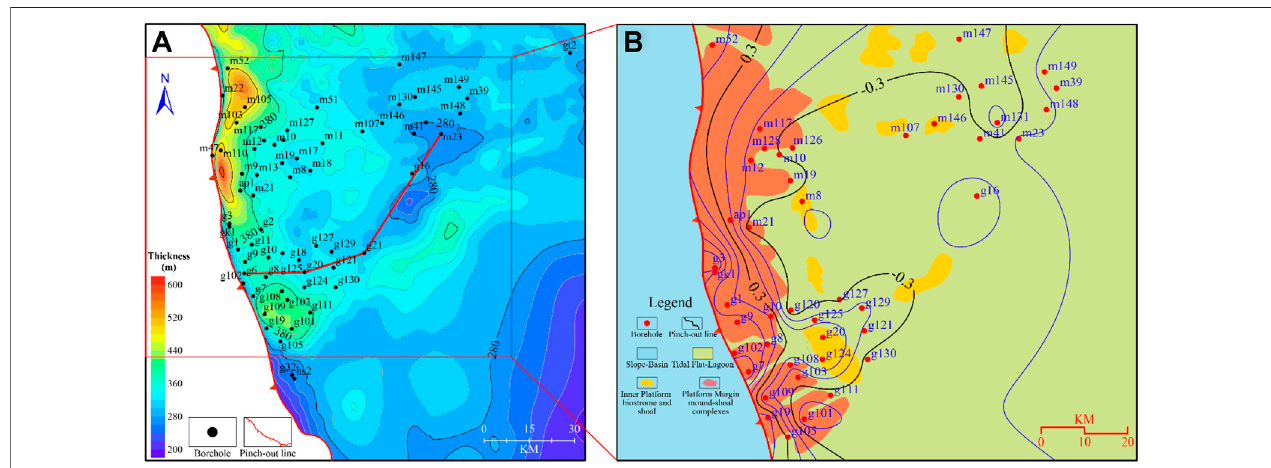
FIGURE 6 | (A) converted residual thickness of Deng Ⅳ and Z 2 dn 3 s based on seismic data. Note the banded convex structure along the pinch-out line, which referstothegreaterthicknessintheplatformmargin.DuetotheinferiortraceabilityoftheinterfacebetweenthetwomembersandtheverythinthicknessoftheZ 2 dn 3 ,the combined thickness is an acceptable approximation for the thickness distribution of the Z 2 dn 4 . (B) sedimentary facies of the Z 2 dn 4 in the GMA superimposed with the reservoir evaluating line. The sedimentary base map is modi fi ed from Zhou et al. (2017) and Li A. P. et al.